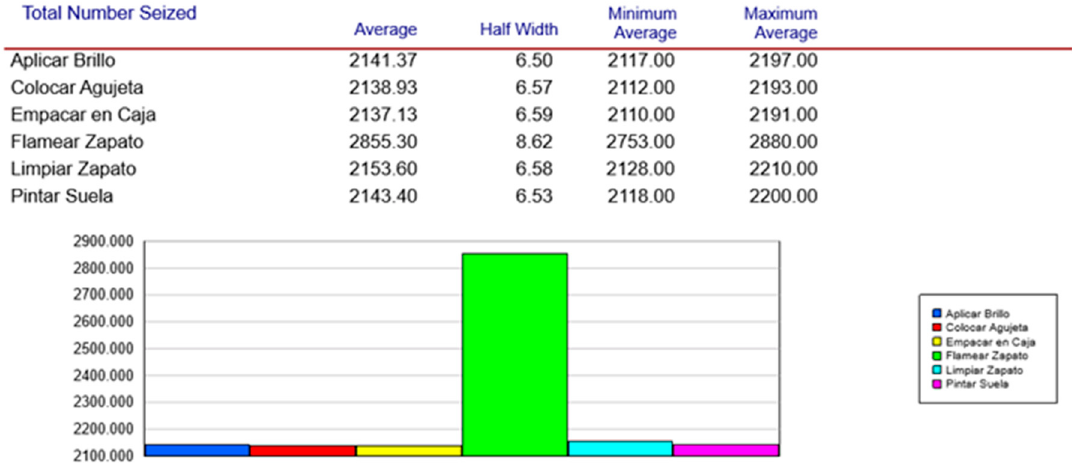
Figure A5. Final production of each activity during the process with a 7.5 h shift, Current.